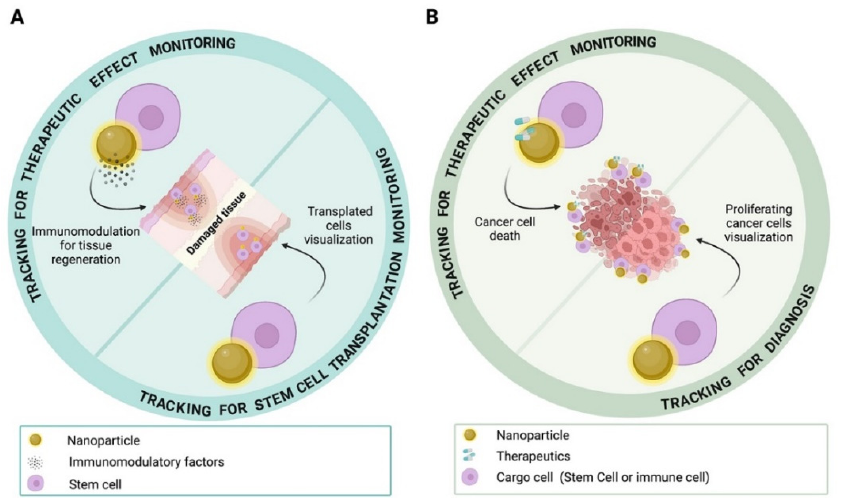
Figure 2. Direct cell tracking approaches suitable for imaging of cancer and cell transplantation for tissue regeneration, and related objectives. ( A ) Stem cells enclosing NPs can be used for monitoring transplantation events, as well as for directing therapeutic effects by releasing immunomodulatory factors into the tissue site requiring regeneration. ( B ) Stem cells or immune cells enclosing NPs can be adopted for homing in on tumors by allowing diagnosis and/or therapy. Figure created with BioRender. Available online: https://biorender.com/ (accessed on 25 March